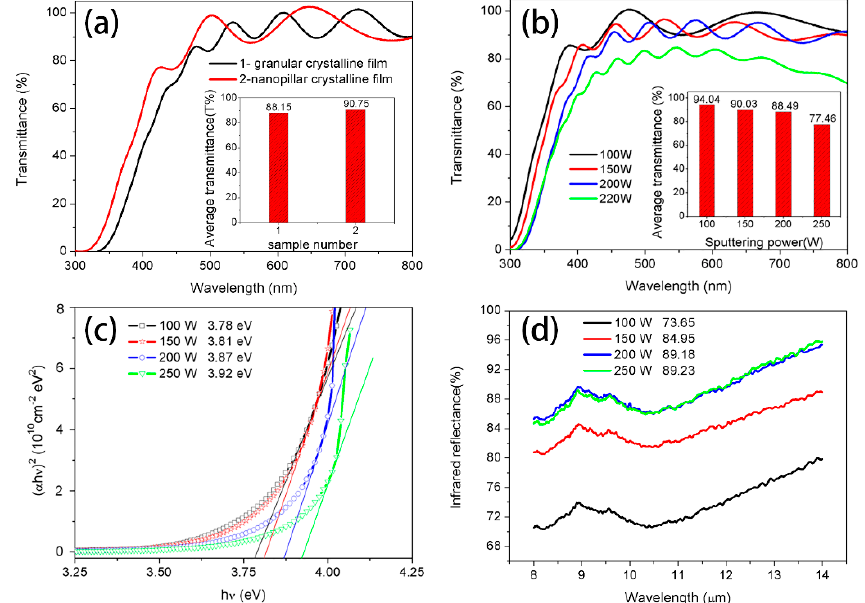
Figure 7. ( a ) Visible light transmittance spectra of monolayer granular and nanopillar crystalline ITO thin film; ( b ) Visible light transmittance spectra of multiple structure nanopillar ITO thin films deposited at different temperature; ( c ) Energy band gaps of the multiple structure nanopillar films; ( d ) IR reflectivity of multiple structure nanopillar films in mid-infrared region.